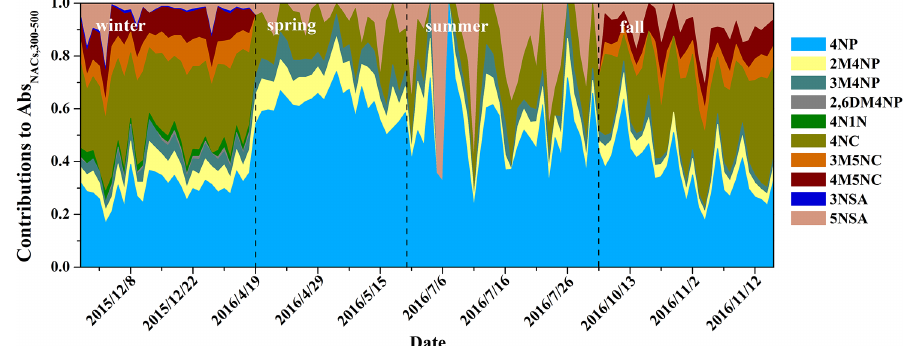
Figure 7. Daily contributions of individual NACs to light absorption of total NACs at wavelengths of 300–500nm. The full names of the compounds are given in Table